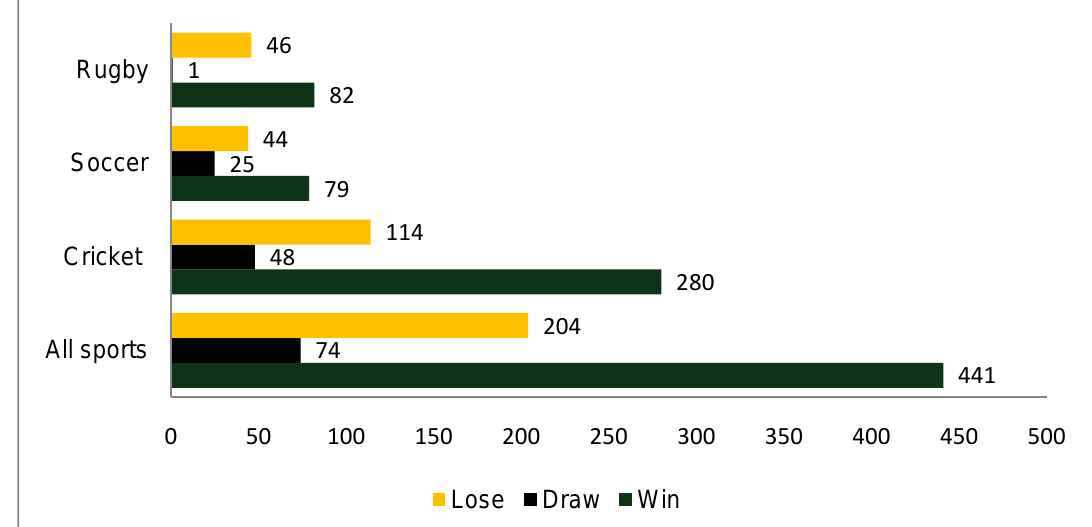
Figure 1: Sports results by category and result